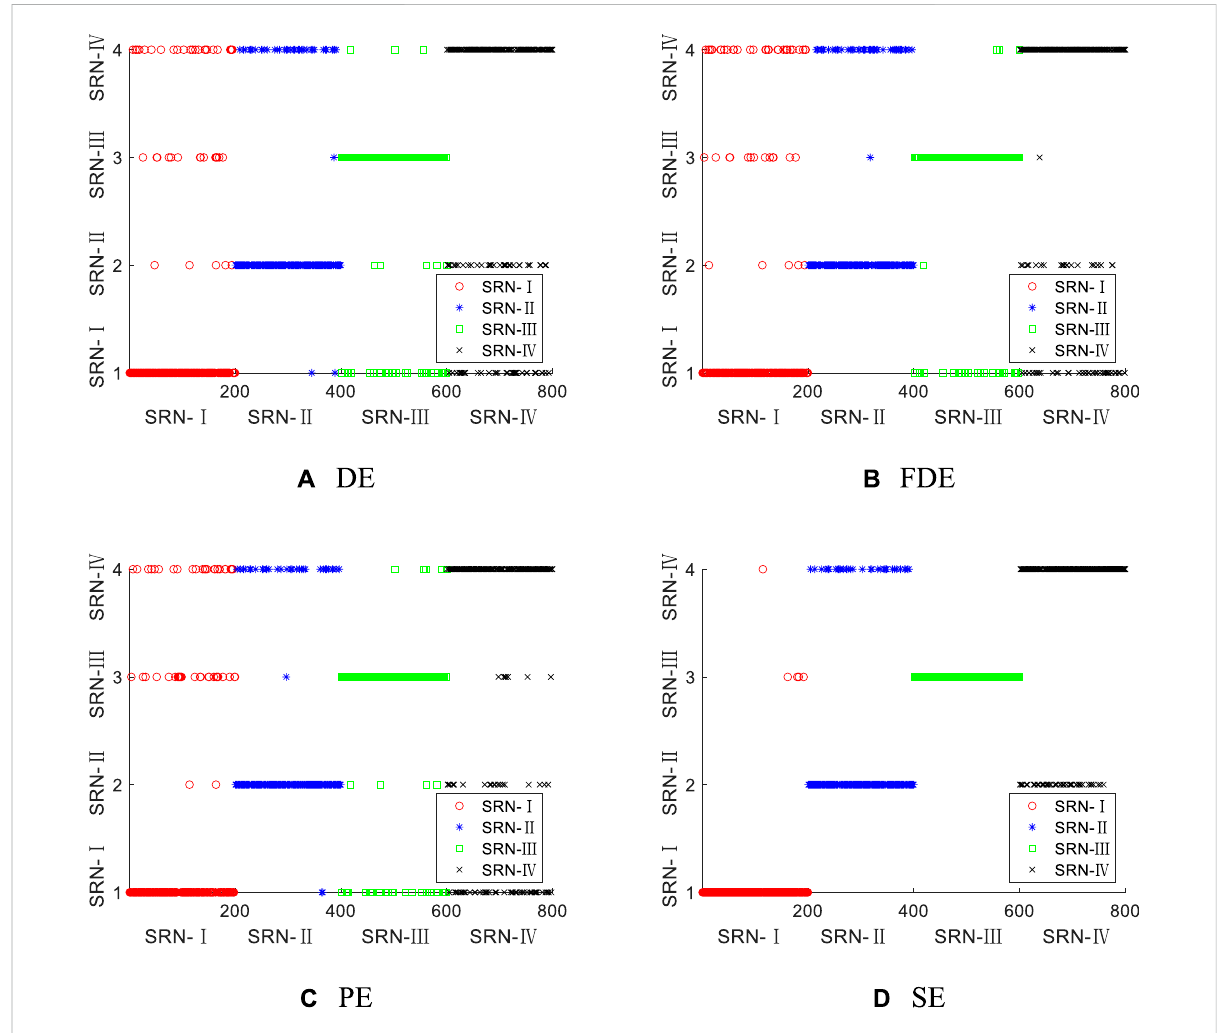
FIGURE 7 Single feature classi fi cation results of four types of entropy for four types of SRN. (A) DE (B) FDE (C) PE (D)